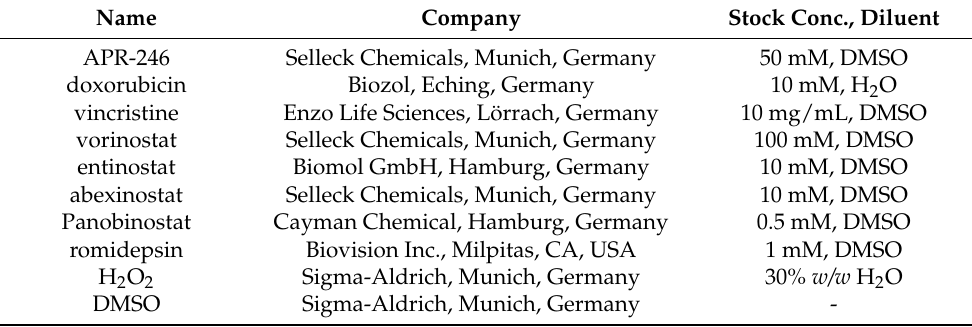
Table 1. Chemicals, reagents and diluents